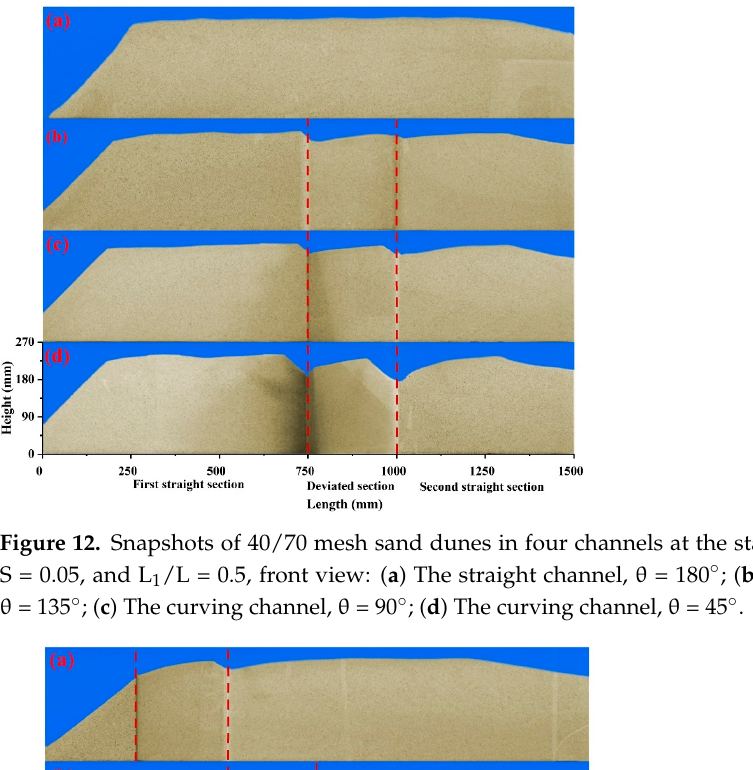
Energies 2022 , 15 , x FOR PEER REVIEW 13 of 17